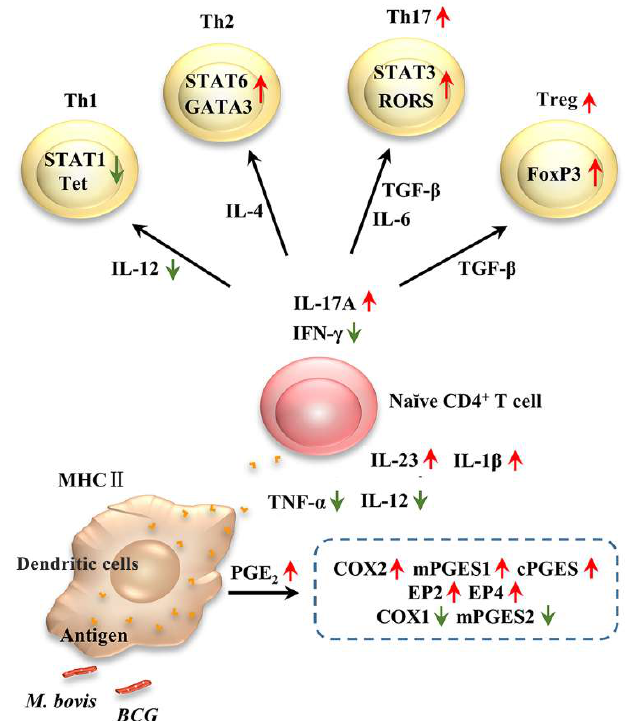
Figure 10. Differentiation of CD4 + T cell subsets under the corresponding cytokine atmosphere stimulated by M. bovis and BCG infected DCs. Arrows represent the main significantly differential expression of molecules in DCs and CD4 + T cell subsets induced by infection with M. bovis compared with BCG: green arrow indicating down-regulation, while red arrows up-regulation.